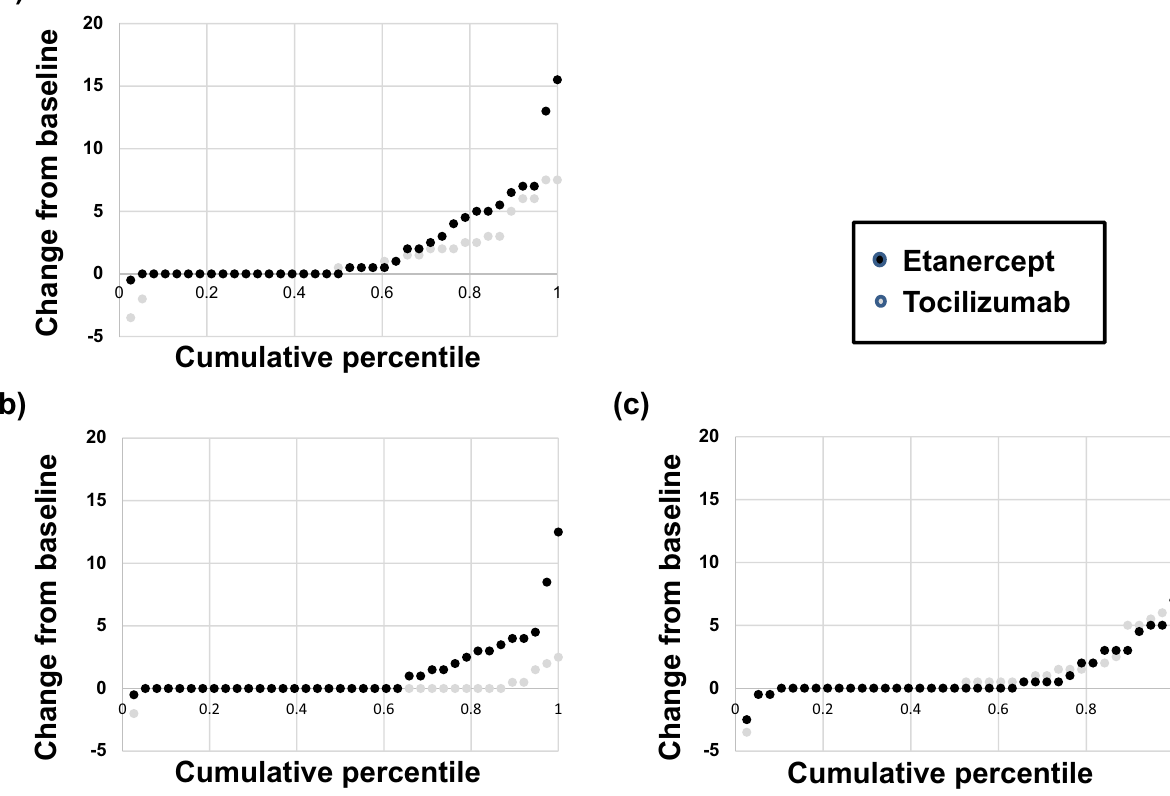
Figure 1. Radiographic progression in structural joint damage was evaluated using cumulative distribution of mTSS change from baseline at one year. Black dots represent the progression of etanercept and gray dots represents the progression of tocilizumab ( a ) delta mTSS ( b ) delta erosion ( c ) delta